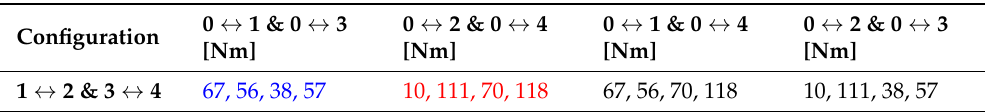
Table 2. Maximum shaft torques resulting from cylinder loads, lower pressure level, and necessary displacements for different interconnection schemes with VDN-PP topology. The Blue colored case marks the scheme with the lowest torque sum and the red colored case marks the scheme with the highest torque sum.